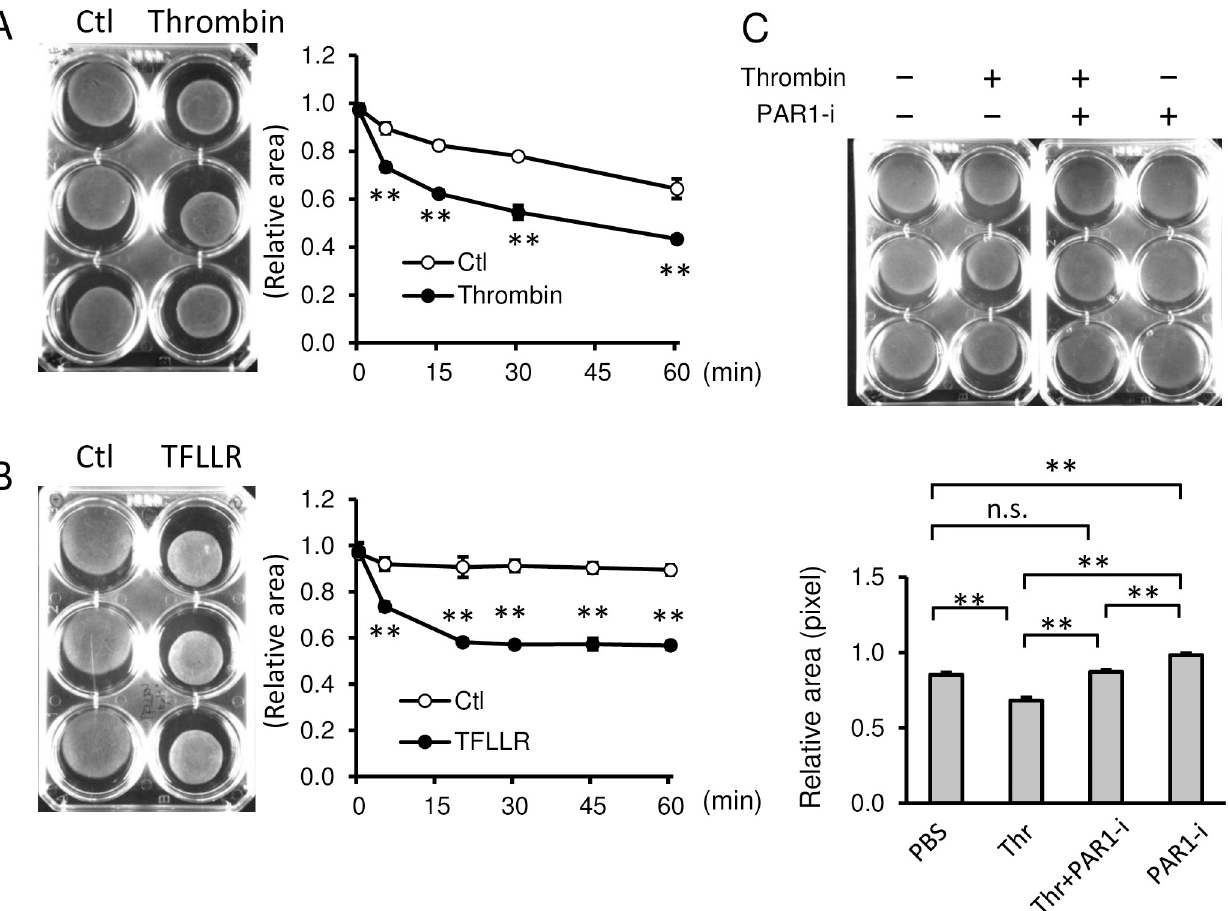
Fig 2. Thrombin increased contraction of primary human myometrial cells through PAR1. (A and B) (Left images) Representative images of collagen lattice assay of human myometrial cells at 30 min treated with PBS (Ctl) and thrombin (A) or PAR1 activating peptide, TFLLR (B) . (Right graphs) Quantification of myometrial contractions in collagen lattice assays (n = 3). �� , p < 0.01 at each time point. (C) Collagen lattice assay of myometrial cells at 30 min with 2 U/mL of thrombin (Thr) pretreated with or without 100 nM PAR1 selective inhibitor (SCH79797, PAR1-i) for 1 h (n = 3). Representative image (upper panel) and quantification of gel areas (lower graph). The experiments were repeated three times. � , p < 0.05, and �� , p < 0.01.